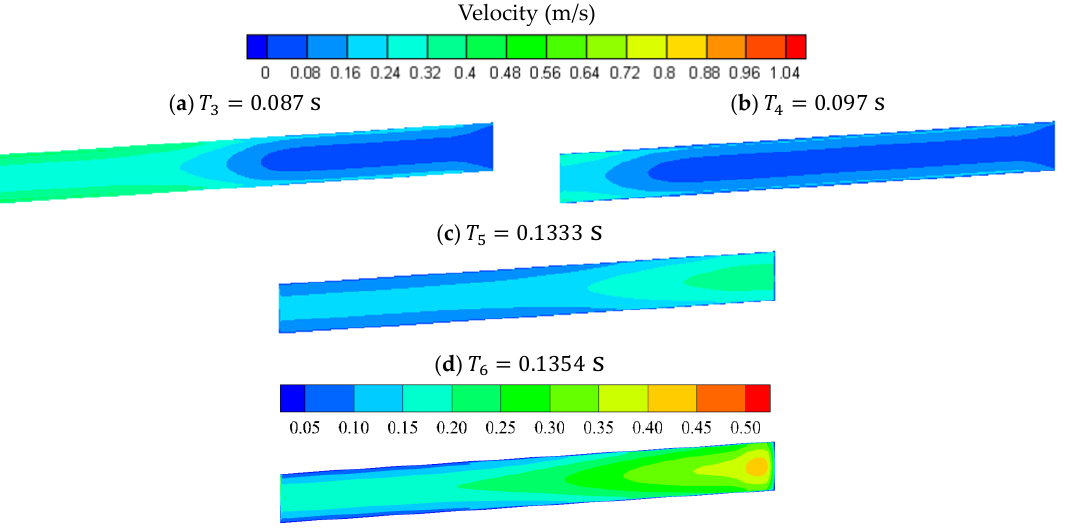
Figure 35. Velocity field evolution on the axis plane of the pipeline in the cavity collapse stage.